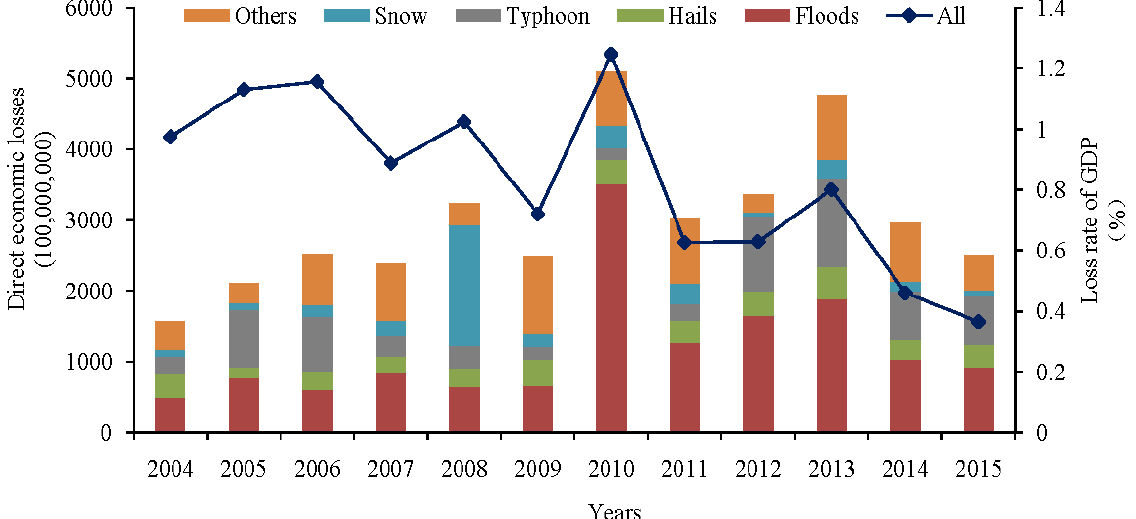
Figure 2. Direct economic losses caused by floods, hail, typhoon, snow and others and loss rates of GDP caused by all the meteorological disasters, 2004 – 2015. Others: rain, smoke flog, low altitude GDP caused by all the meteorological disasters, 2004–2015. Others: rain, smoke flog, low altitude wind shear, acid rain, forest fire, air pollution and soon on. wind shear, acid rain, forest fire, air pollution and soon